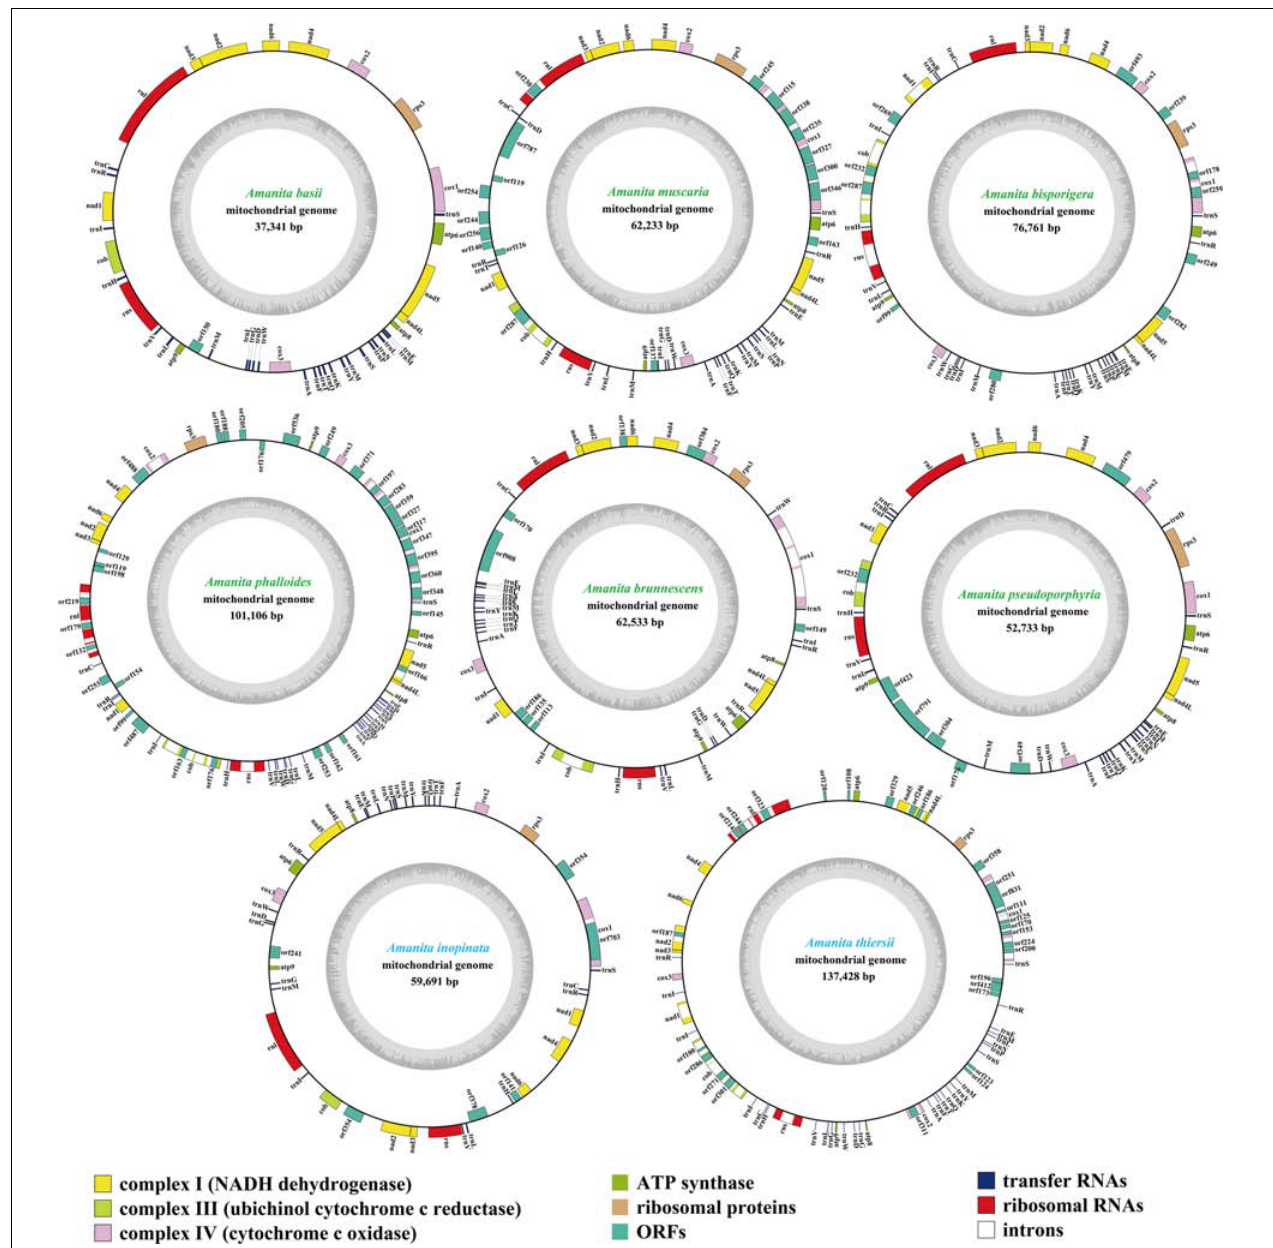
FIGURE 1 | Circular maps of the mitogenomes of eight Amanita species. Genes are represented by different colored blocks. Colored blocks outside each ring indicate that the genes are on the direct strand, whereas colored blocks within the ring indicate that the genes are located on the reverse strand. The Amanita species with blue fonts are asymbiotic, while the species with green fonts are